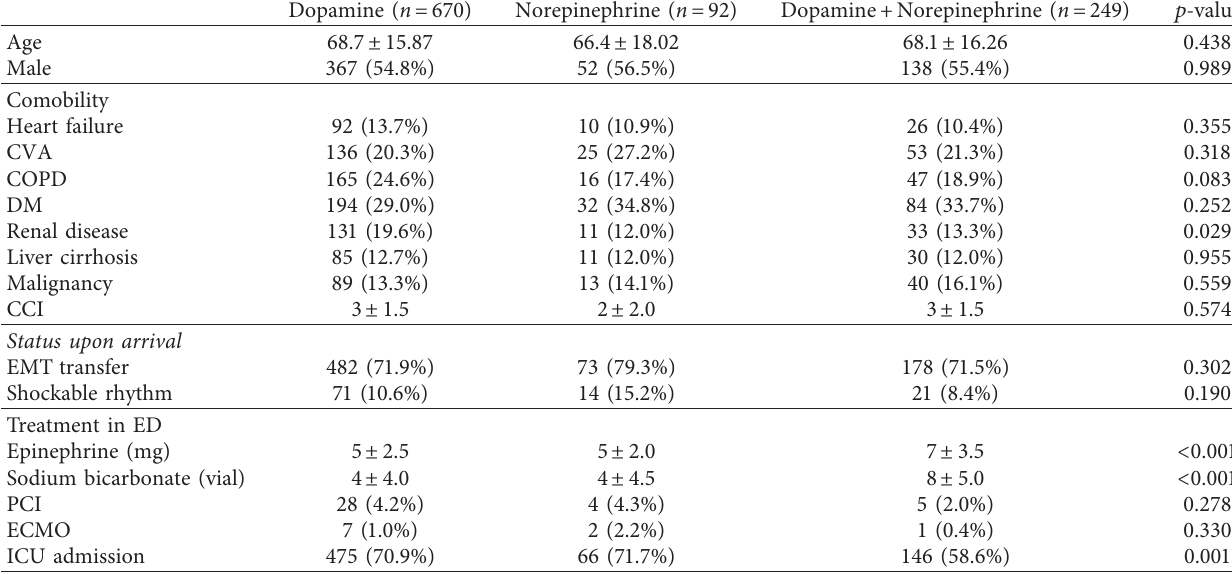
Table 1: Characteristics of patients treated with different inotropic agents after return of spontaneous